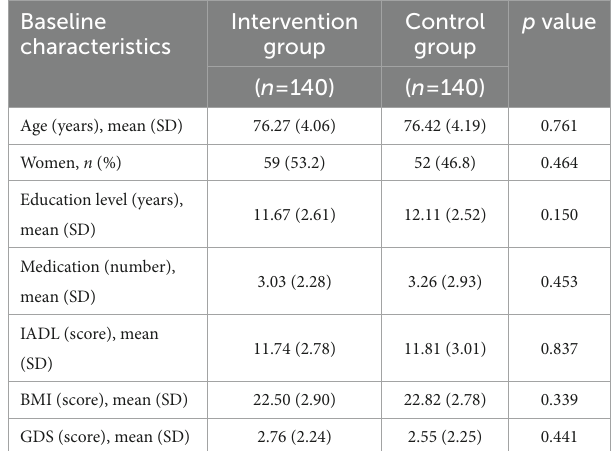
TABLE 1 Demographic and clinical characteristics of the participants at